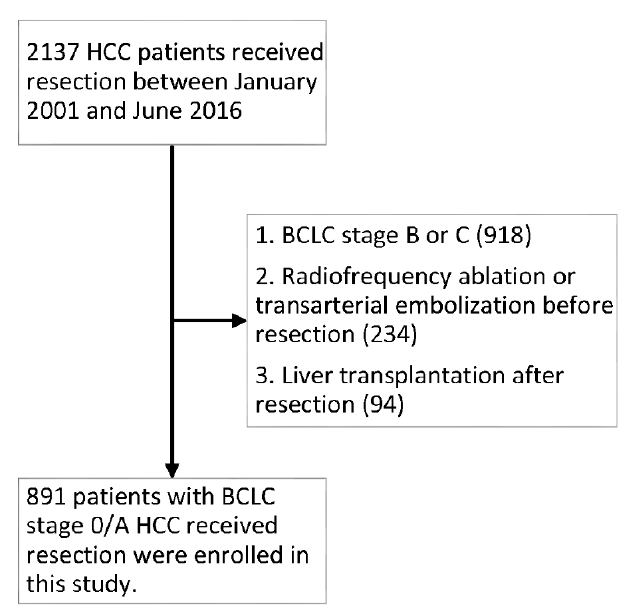
Figure 1. Flow chart of patients included in this study. HCC, hepatocellular carcinoma; BCLC, Barcelona Clinic Liver Cancer.